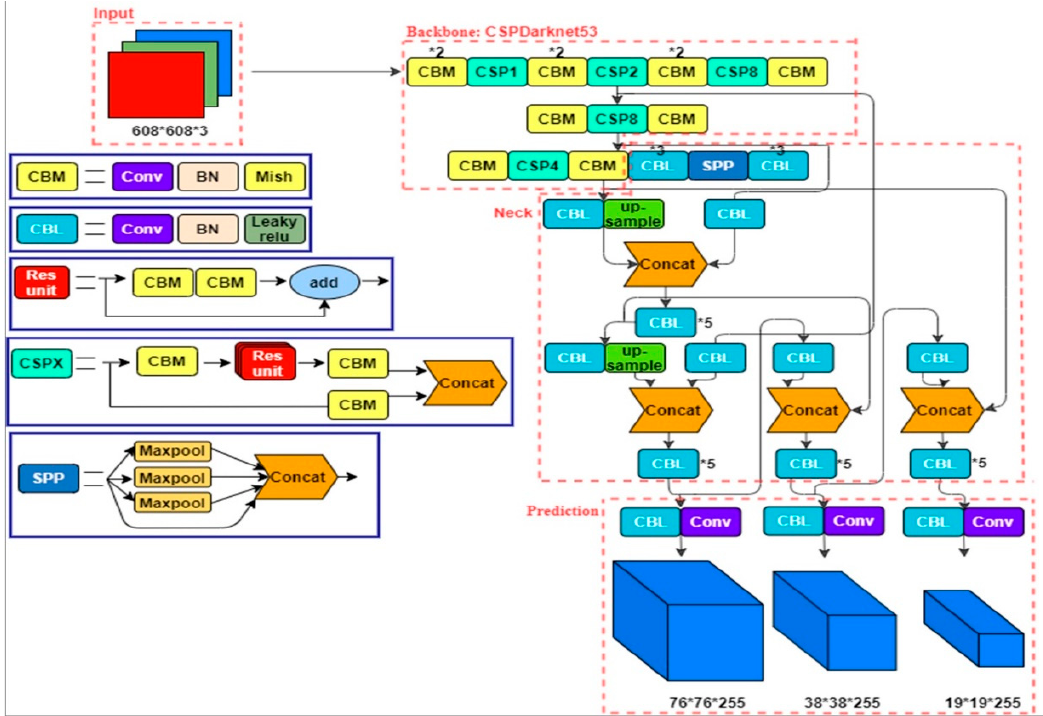
Figure 3. YOLOv4 network architecture (*2 on the CBM layer indicates that two CBM layers are used; *3 on the CBM layer indicates that three CBM layers are used; *5 on the CBM layer indicates that five CBM layers are used.).